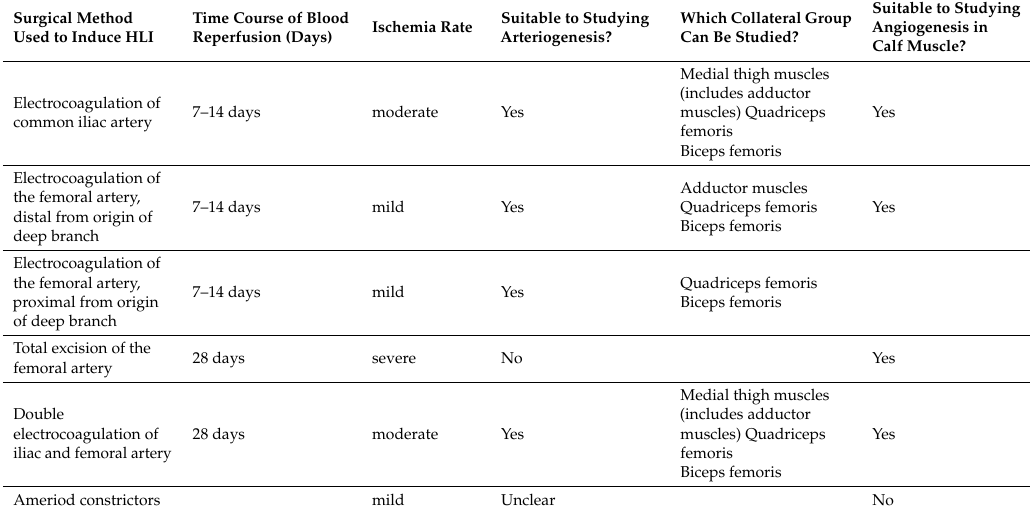
Table 1. Surgical methods used to induce hind limb ischemia, time course of blood reperfusion recovery, whether the method is suitable to assess arteriogenesis and angiogenesis, and if arteriogenesis takes place, where it will take